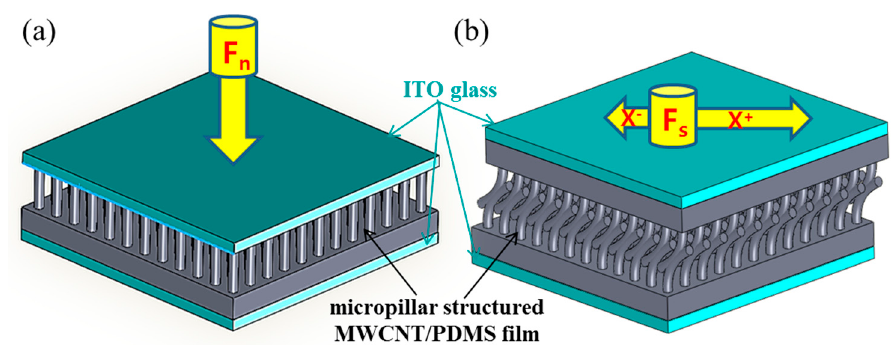
Figure 1. 3D schematics of the concept of MWCNT/PDMS tactile sensors; ( a ) enhancing the sensitivity of a single MWCNT/PDMS film-based tactile sensor with stiff micropillar surface texture under applied normal pressure; ( b ) directional sensitivity of a double MWCNT/PDMS film-based tactile sensor having interlocked curved-shape micropillars under applied shear pressure (the longer arrow means a larger resistance change under same magnitude of applied shear pressure).